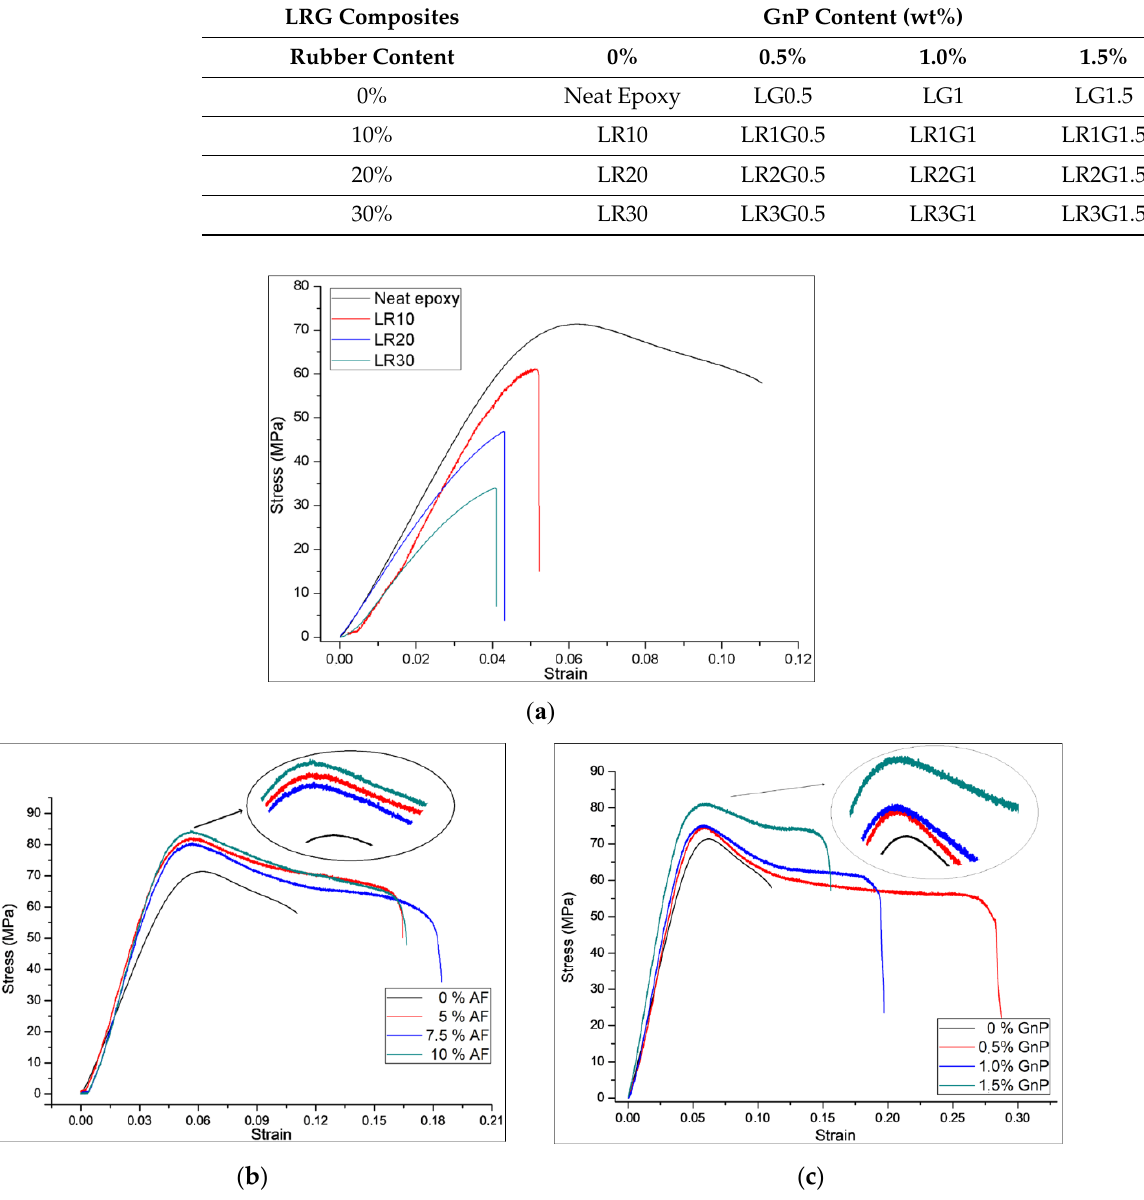
Figure 4. Comparison of stress-strain curves of ( a ) recycled EPDM rubber composites (LR). ( b ) AF reinforced epoxy-based composites (LAL). ( c ) GnP reinforced epoxy-based composites (LG) [54].